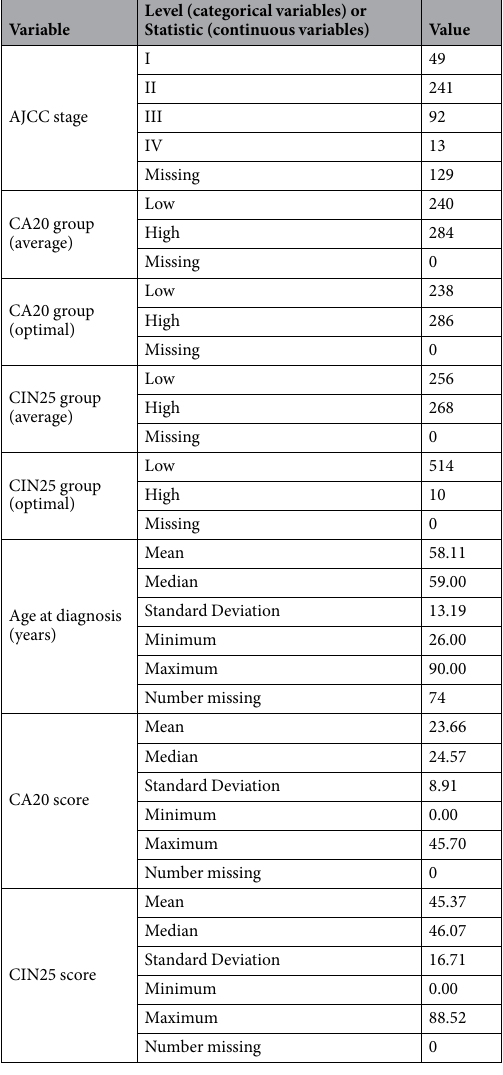
Table 2. Descriptive statistics for the TCGA breast dataset.